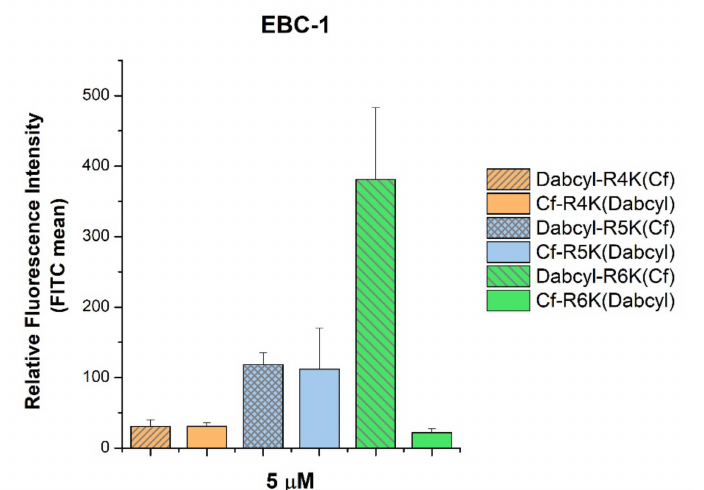
Figure 3. Effect of the position of Dabcyl and Cf on the cellular uptake of short oligoarginines into EBC-1 cells. The cells were treated with peptides at a concentration of 5 µ M at 37 ◦ C for 90 min. After trypsinization the fluorescence intensity of cells was determined using flow cytometry. The fluorescence intensities were normalized to the fluorescence intensity of cells that were treated with Cf-Arg 8 (100%). Any significant difference between the control Cf-Arg 8 and peptides with the same amount of arginine was measured using the Student’s t test. No significant difference was found.